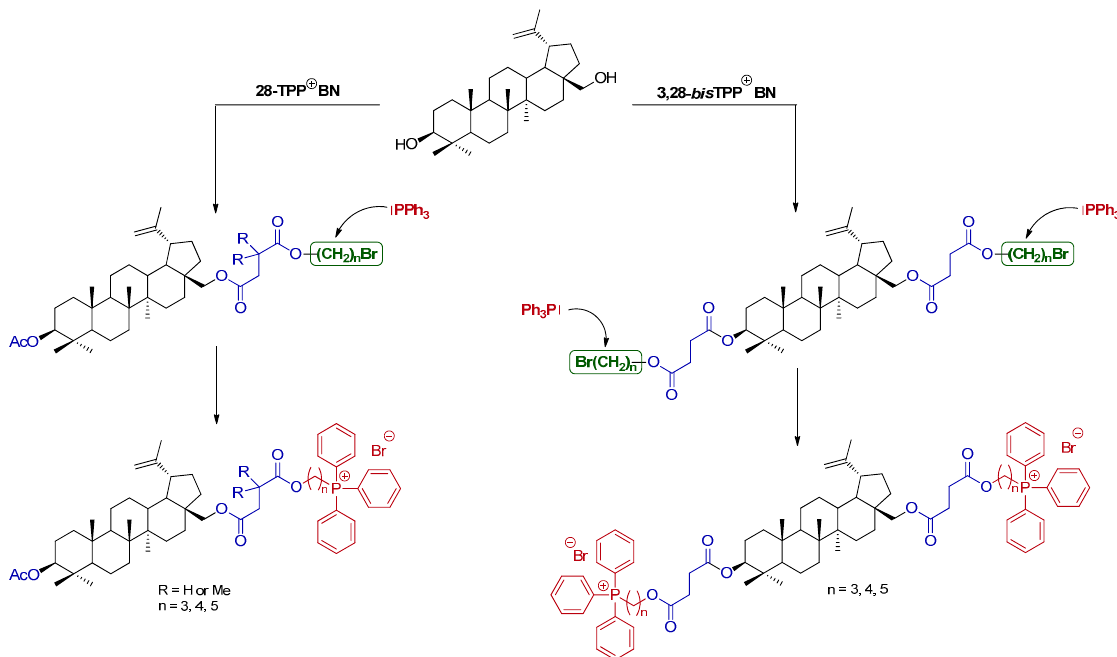
Figure 4. The chemical structures of the TPP ⊕ -conjugated with BN